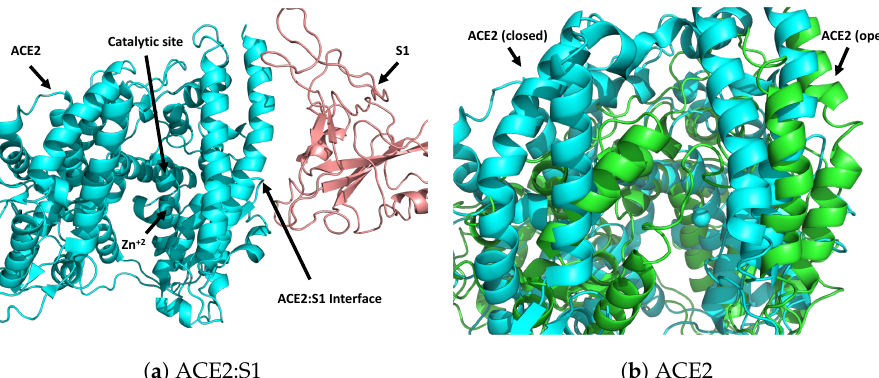
Figure 1. Crystal structures showing interaction between human ACE2 and S1 domain of viral S-protein. ( a ) Viral S1 fragment of the S-protein co-crystallized with ACE2. Only closed conformation can be co-crystallized suggesting ACE2 conformational dependency for S1 interaction [14]. ( b ) Closed and Open conformation of ACE2. Zn cation is not detected in the open conformation. ACE2 freely explores both open and closed conformations